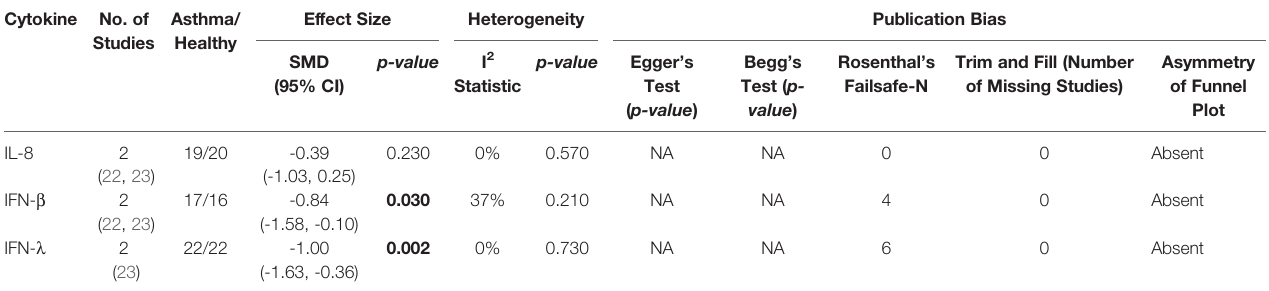
Cytokine No. of Asthma/ Studies